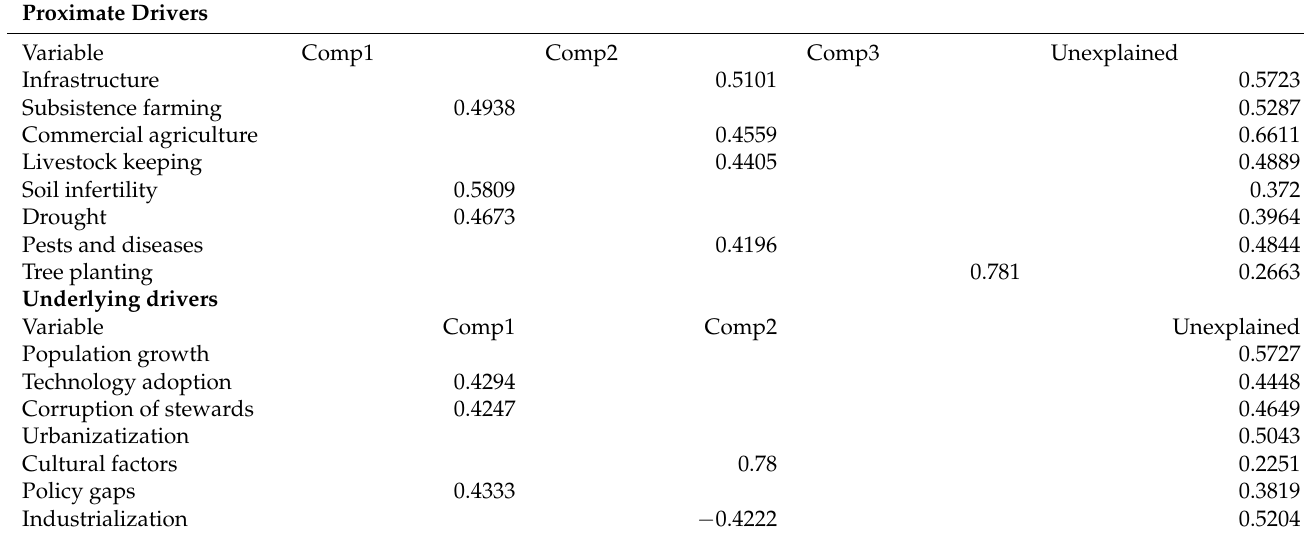
Table 1. Proximate and underlying drivers of LULCC in Budongo–Bugoma